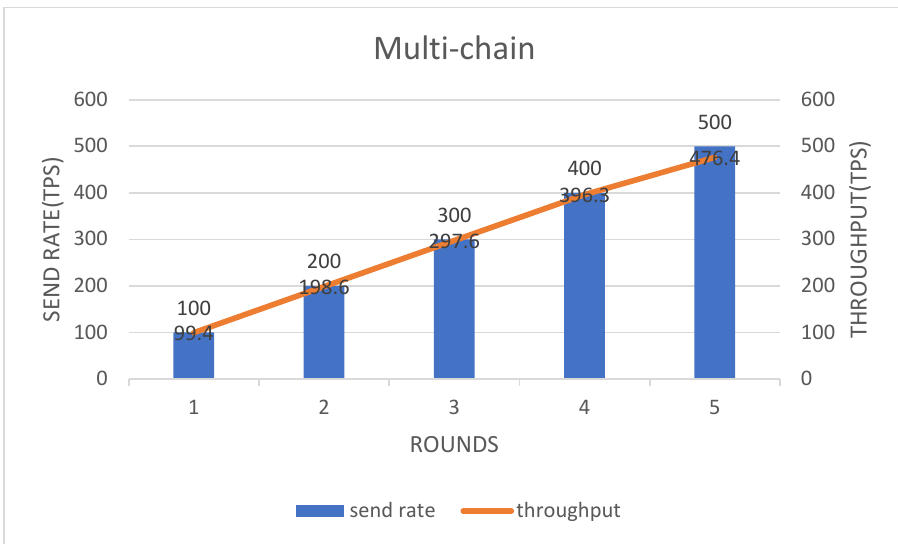
Figure 28. Transaction throughput evaluation of multi-chain architecture.